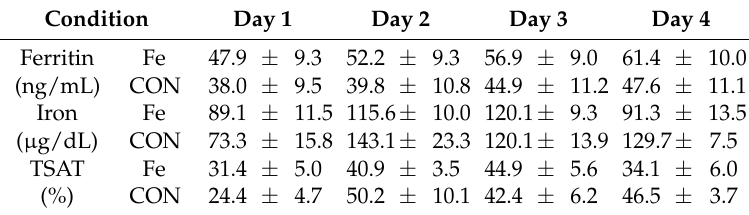
The values are means ± SE. Serum ferritin: interaction (condition × time): p = 0.504 (ES = 0.005), main effect for condition: p = 0.445 (ES = 0.05), main effect for time: p = 0.008 (ES = 0.47). Serum iron: interaction (condition × time): p = 0.069 (ES = 0.19), main effect for condition ( p = 0.321, ES = 0.08), main effect for time: p = 0.001 (ES = 0.36). Serum TSAT: interaction: p = 0.056 (ES = 0.19), main effect for condition: p = 0.598 (ES = 0.02), main effect for time: p = 0.001 (ES =